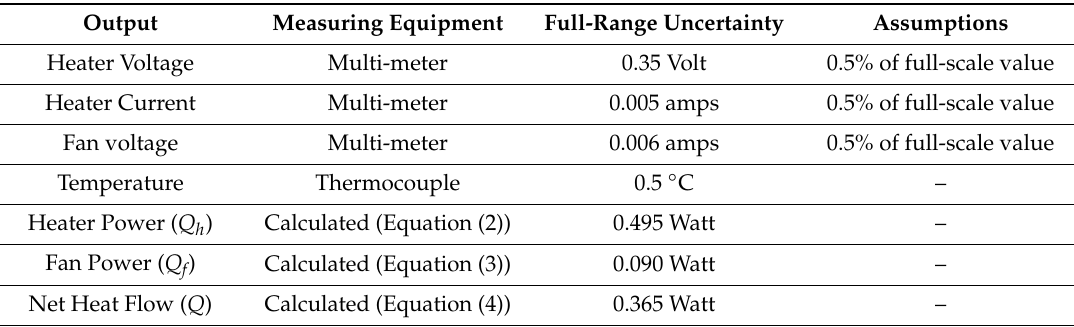
Table 2. Full-range uncertainties in measurement equipment